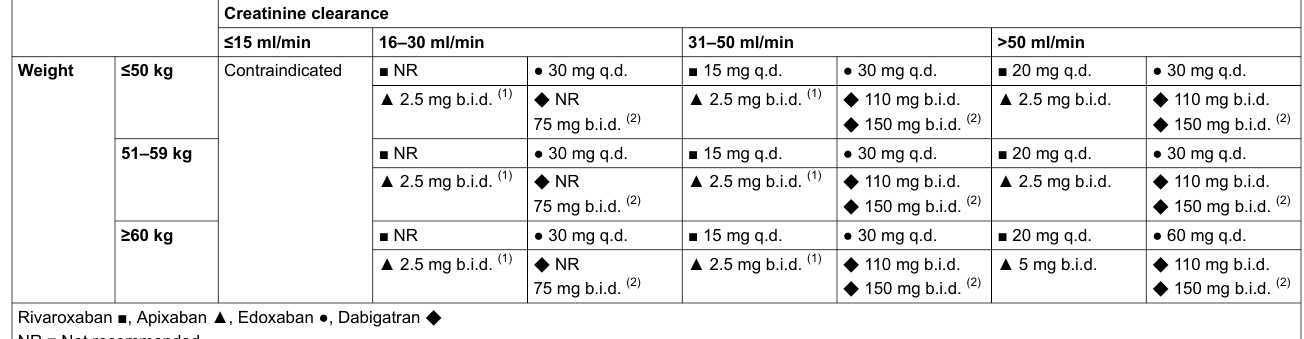
Table 3: Dose recommendation for stroke prevention in patients ≥80 years old with nonvalvular atrial fibrillation. Creatinine